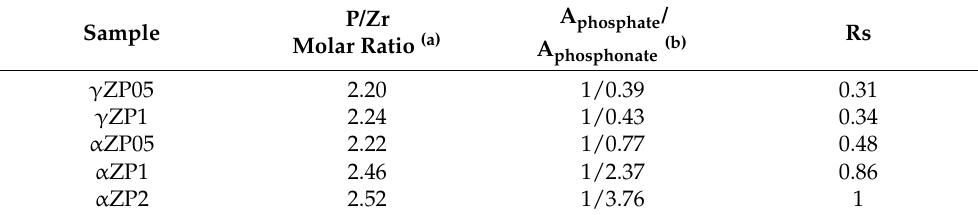
Table 1. ALN/Zr molar ratios in the solids (Rs) of γ ZP-ALN and α ZP-ALN samples. A phosphate / P/Zr Sample Molar Ratio (a)